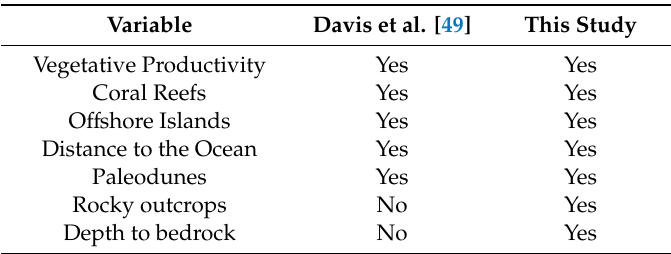
Table 1. List of di ff erent variables incorporated in Davis et al. [49] and the models developed in this